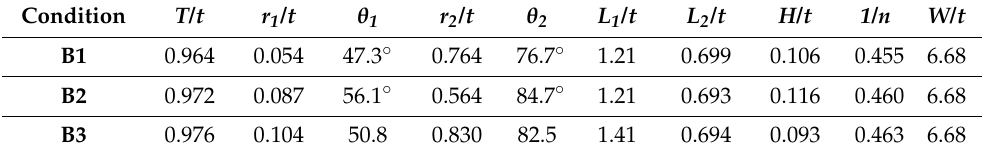
Table 3. The measured geometric